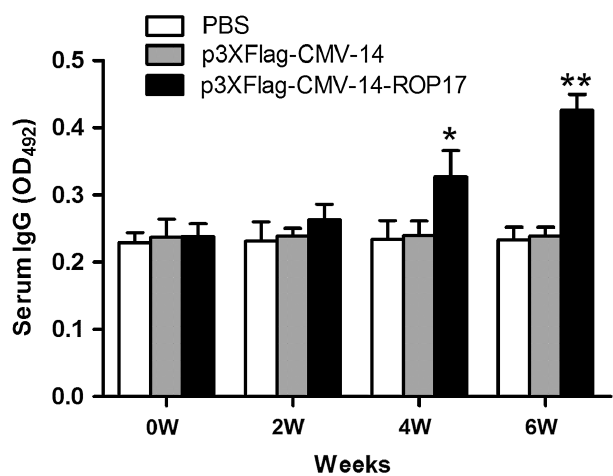
Figure 1. Dynamics of antibody production in ROP17 DNA- immunized BALB/c mice and controls. Levels of specific anti- ROP17 IgG titers in the sera of various BALB/c mice were determined by ELISA under the same conditions. Results are expressed as means ± SD ( n = 6). * P < 0.05, ** P < 0.01 relative to control